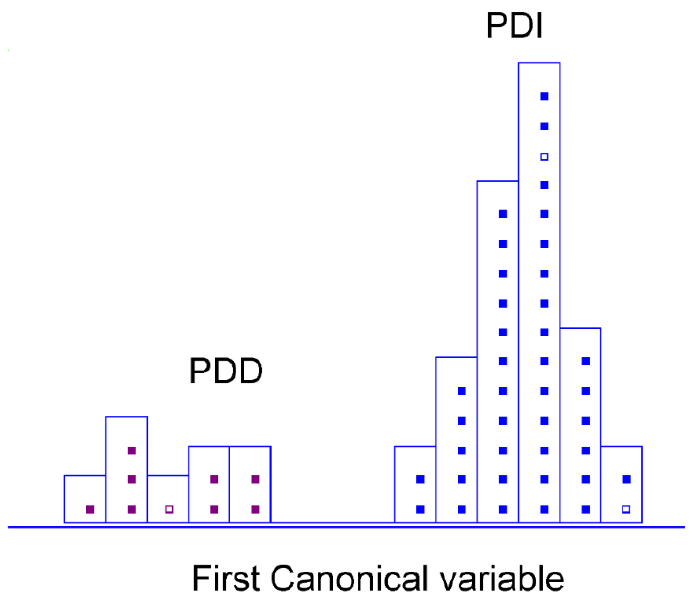
Figure 4. Histogram of the first canonical variable for the discrimination of PD early stage ( (cid:4) ) and PD-related dementia ( (cid:4) ) patients after performing SELECT-LDA in the PD stratification approach ( y -axis indicates the maximum discrimination power between categories). Table 4. Discriminant wavenumbers (in order of selection) corresponding to the SELECT-LDA clas- sification developed from IR spectra of plasma samples for the differentiation of PD progression stage.